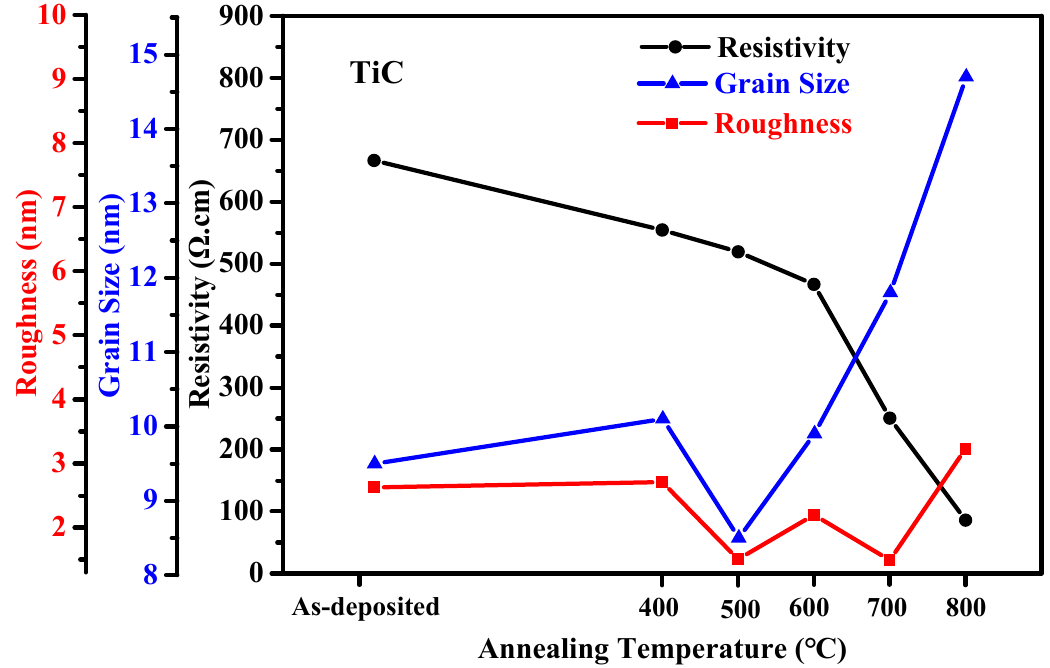
Figure 6. The variations of resistivity, grain size and surface roughness with annealing temperatures for TiC thin films with a thickness of 610 nm.